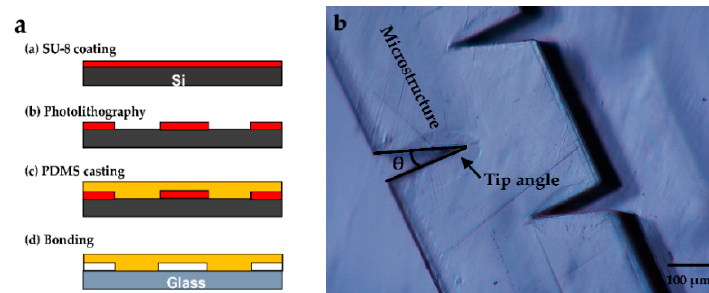
Figure 4. Components of the experimental system.